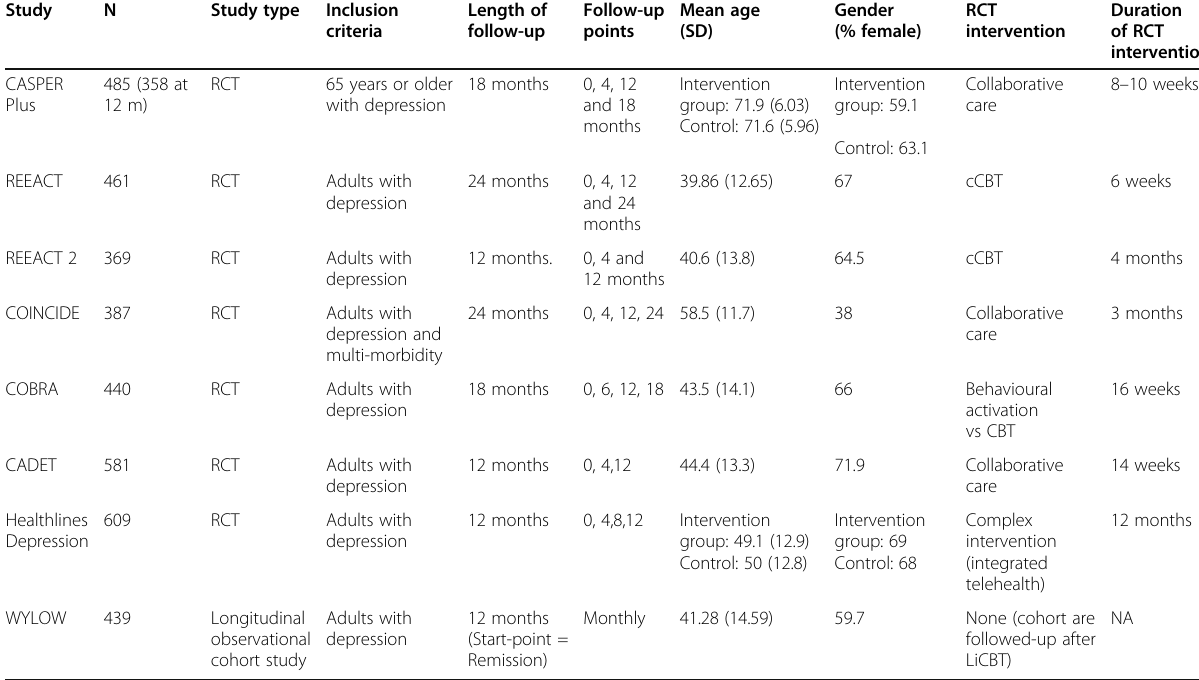
Table 1 Summary of primary sources of